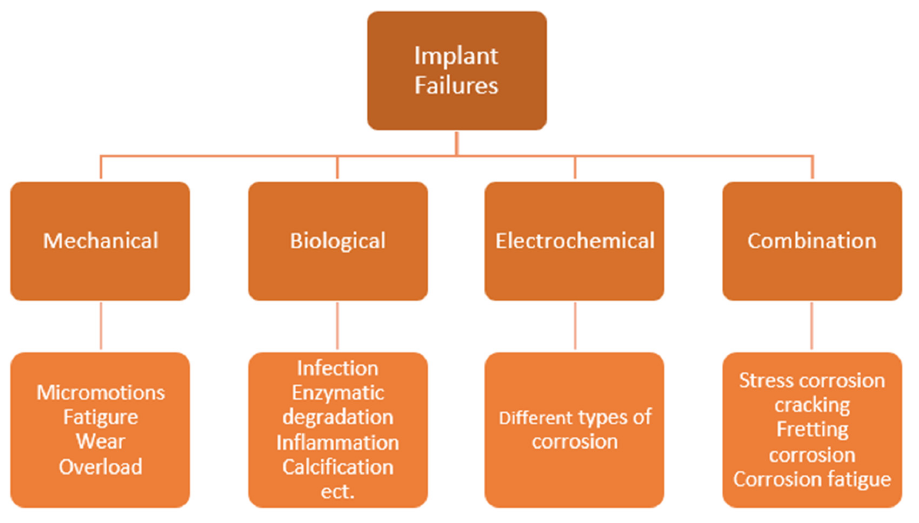
Figure 1. Different forms of implant failures.